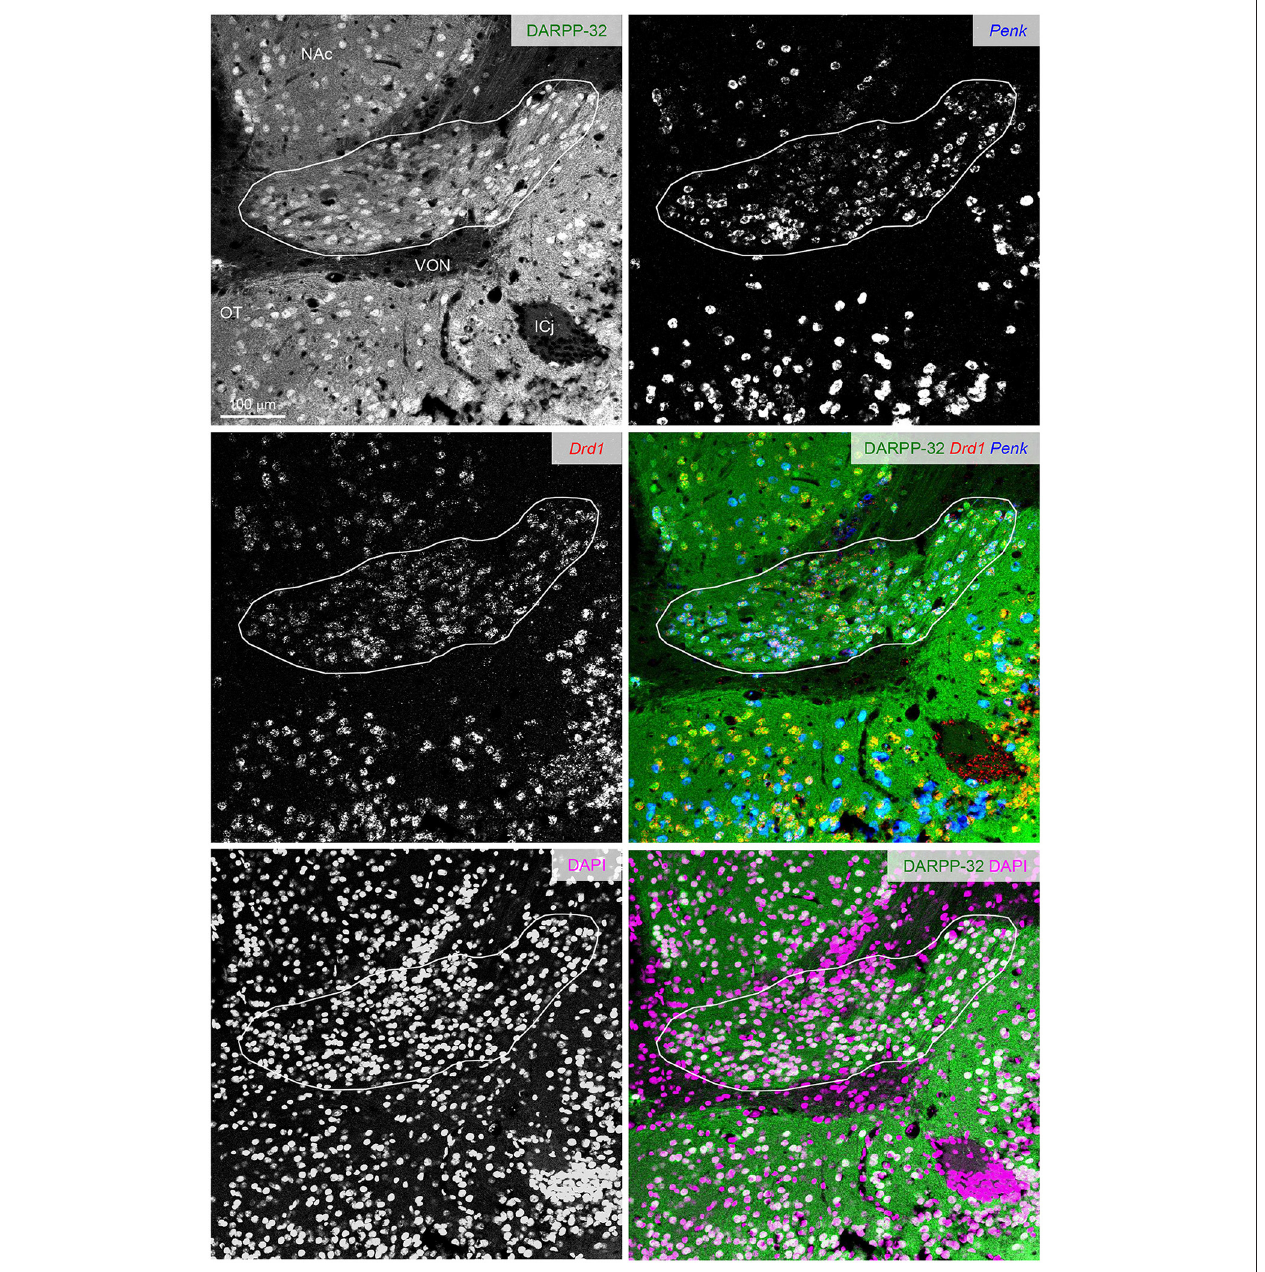
FIGURE 7 | DARPP-32 expression by the putative Pdyn-Penk-Drd1 co-expressing cells in the cell cluster between OT and NAc. Fluorescence images of DARPP-32 immunoreactivity (upper left, green), Penk (upper right, blue), Drd1 (middle left, red) mRNA signals, DAPI (lower left, magenta), and color merged view (middle right; DARPP-32-Drd1-Penk, lower right; DARPP-32-DAPI) in the same region. Regions delineated by white lines are a cluster of putative Pdyn-Penk-Drd1 co-expressing cells. OT, olfactory tubercle; NAc, nucleus accumbens; ICj, Islands of Calleja; VON, ventral olfactory